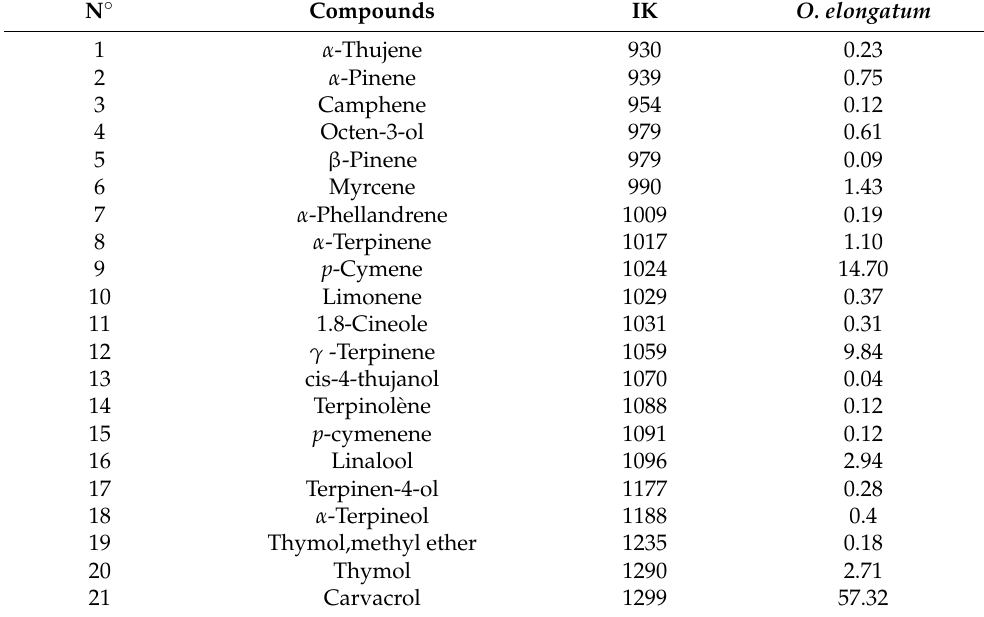
Figure 2. Percentage of the main chemical families of the EO of O. elongatum .